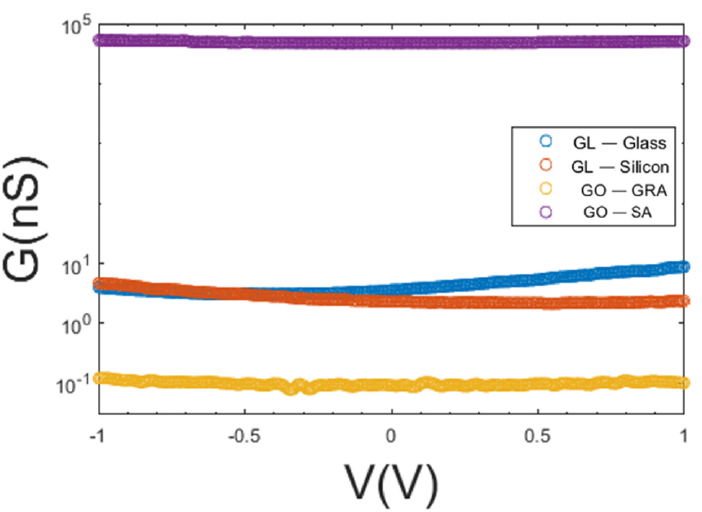
Figure 7. GV curves of four films deposited on different substrates: GL films on glass and Si/SiO 2 ; GO-GRA and GO-SA films both on glass.